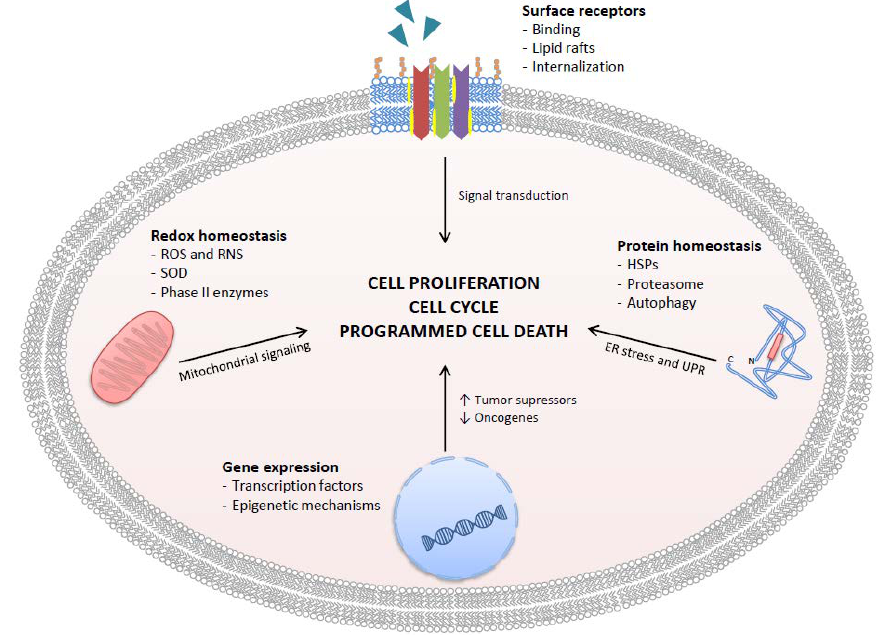
Figure 2. Targets of GTCs in human PCa cells. GTCs inhibit cancer cell proliferation, cause cell cycle arrest, and promote programmed cell death by four main mechanisms: inhibition of ligand-receptor complex formation, redox homeostasis alteration, gene expression control, and protein homeostasis alteration. ROS = reactive oxygen species; RNS = reactive nitrogen species; SOD = superoxide dismutase; HSPs = heat shock proteins